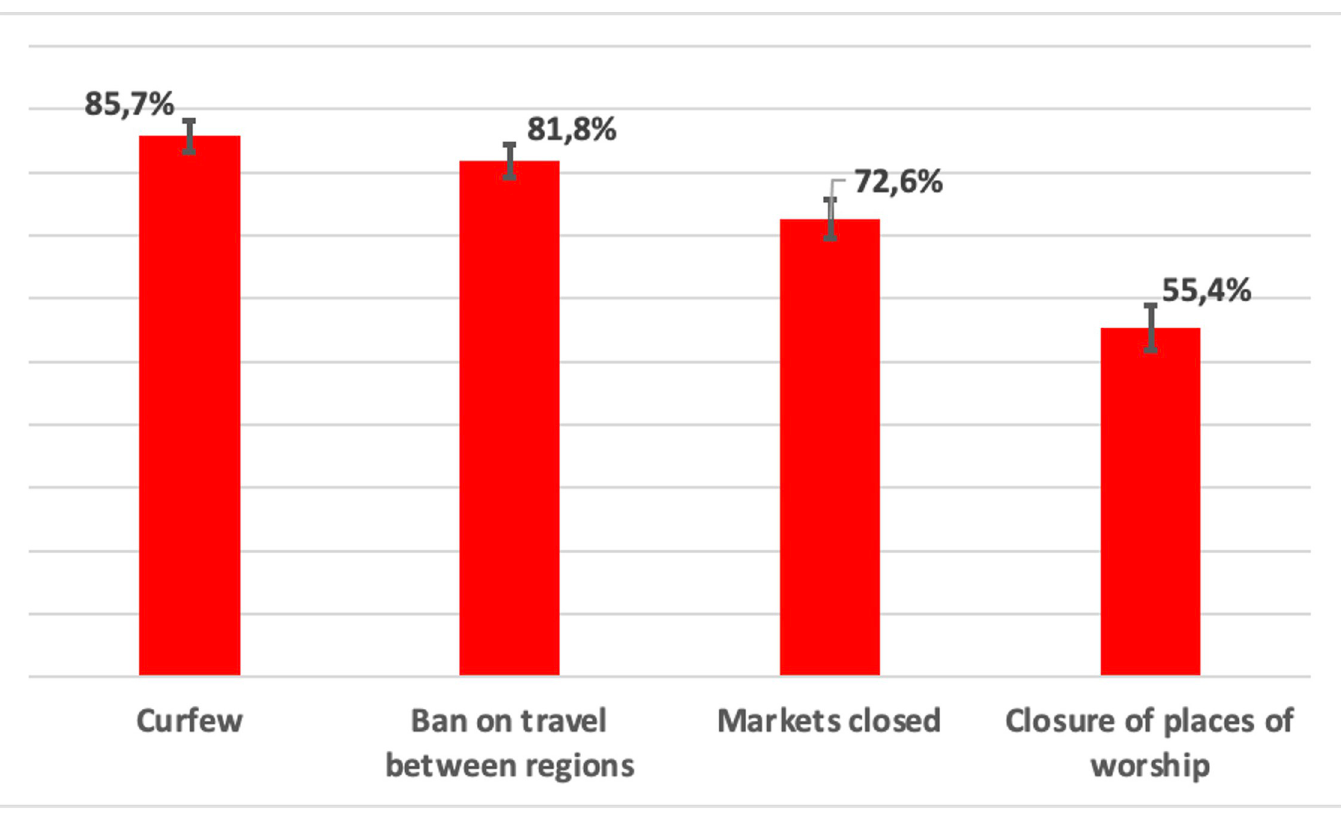
Fig 2. Importance of the four